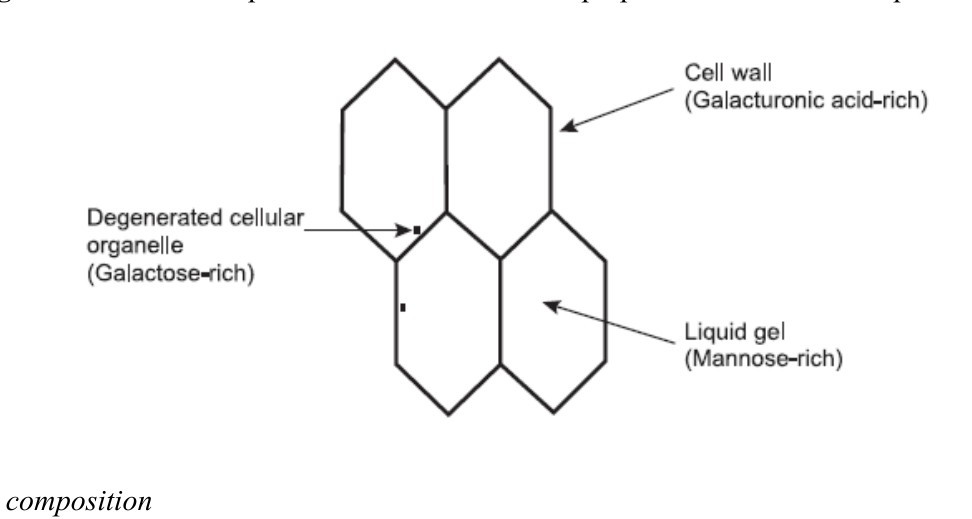
Figure 1. Schematic representation of A. vera leaf pulp structure and its components